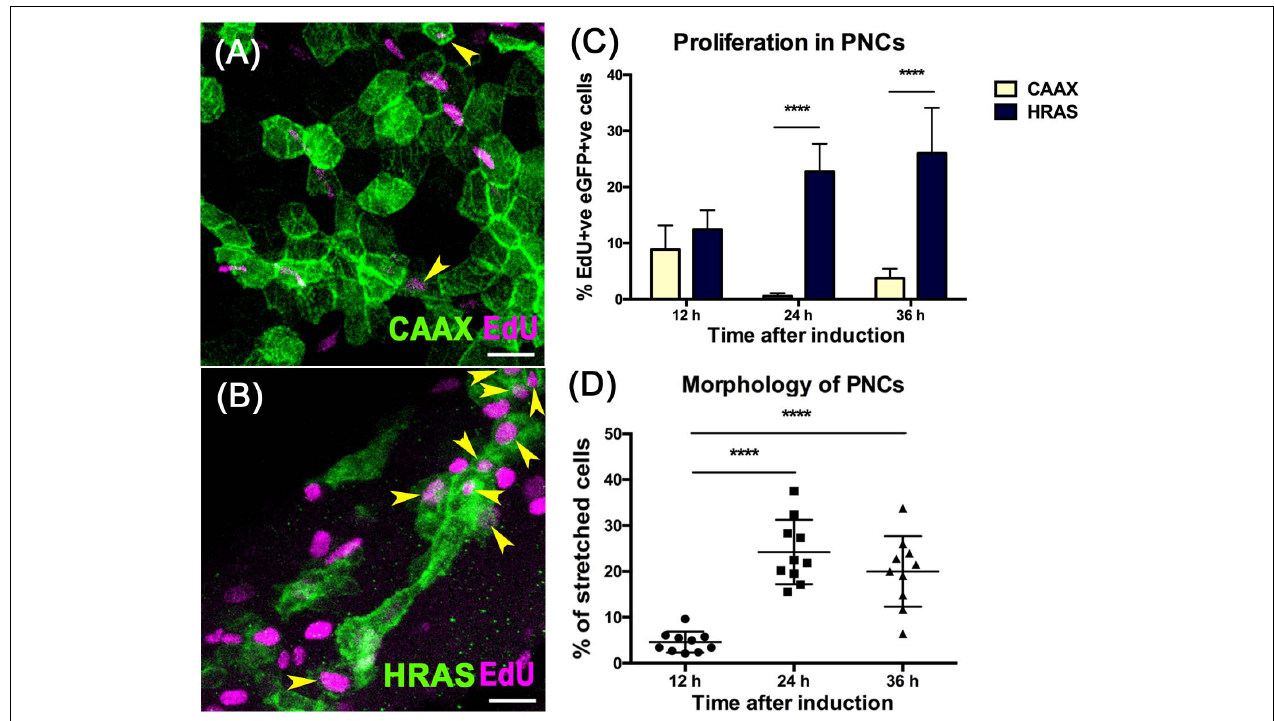
FIGURE 2 | HRAS G12V expressing PNCs show increased proliferation and altered morphology from 24 hpi. (A) Representative confocal image showing EdU labeling (Magenta) in skin cells expressing eGFPCAAX (Green) at 24 hpi. (B) Representative confocal image showing EdU labeling (Magenta) in skin cells expressing eGFPHRAS G12V (Green) at 24 hpi. Yellow arrows indicate EdU + ve eGFP + ve cells, scale bar = 20 µ m. (C) Graph showing increased proliferation in PNCs compared to eGFPCAAX expressing healthy skin cells 12 hpi ( p = 0.057, n = 10); 24 hpi ( p = 3.602e-011, n = 10), 36 hpi ( p = 1,021e-07, n = 10), unpaired t -test with Holm-Sidak method for correction of multiple comparisons. (D) Assessing cell morphology shows that from 24 hpi, a significant proportion of PNCs have lost the normal polygonal shape and become elongated or developed long filopodia (one-way ANOVA with Tukey’s multiple comparisons test, **** p < 0.0001).